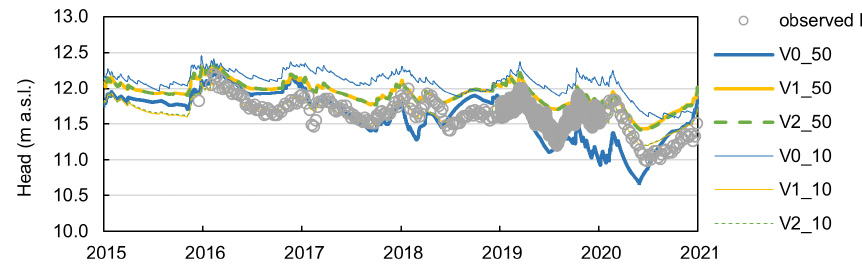
Figure 8. Observed and simulated hydraulic heads for a shallow well screen (145.2424_3; see Fig. 1).